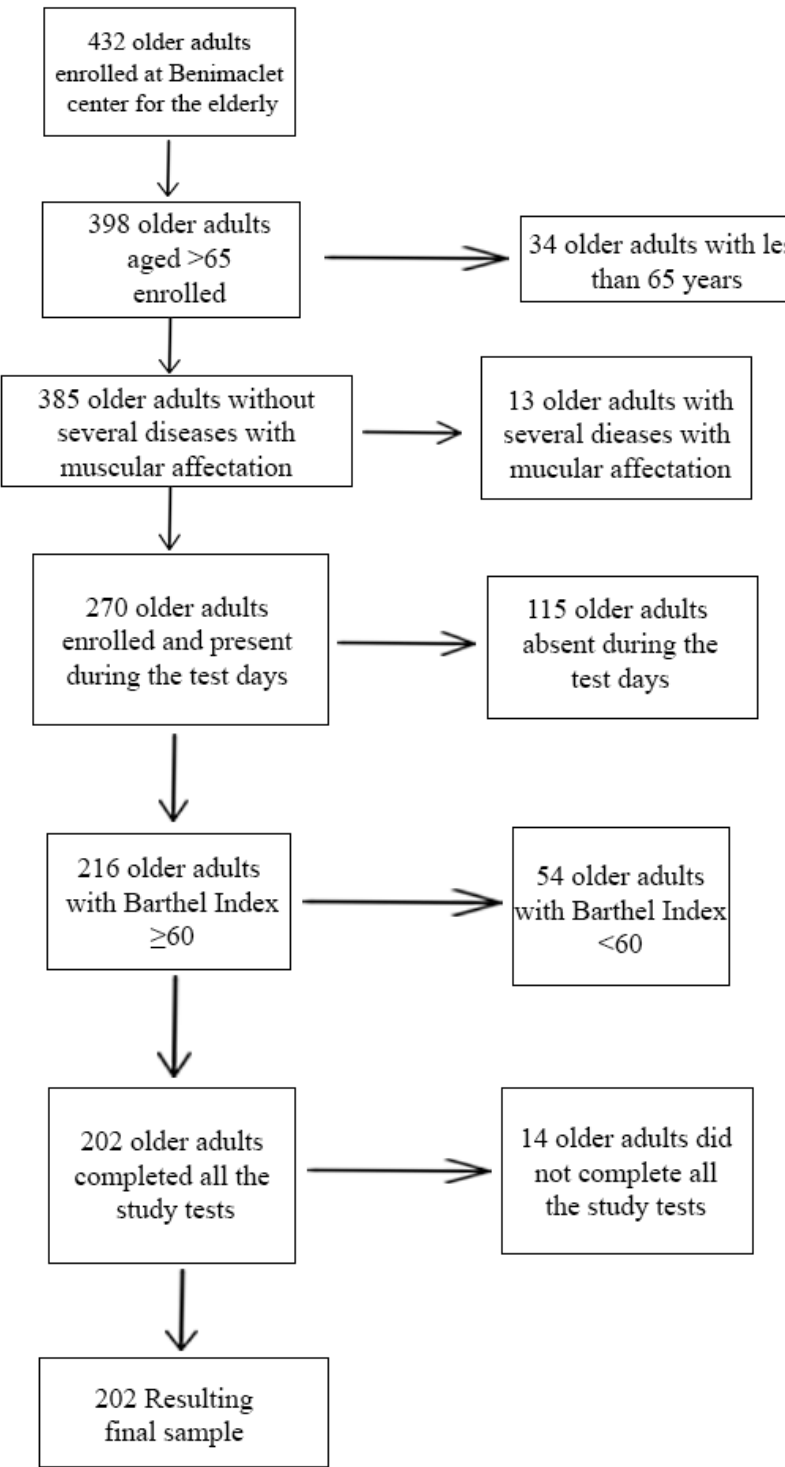
Figure 1. Flow diagram for recruitment of older adults for participation in this study.